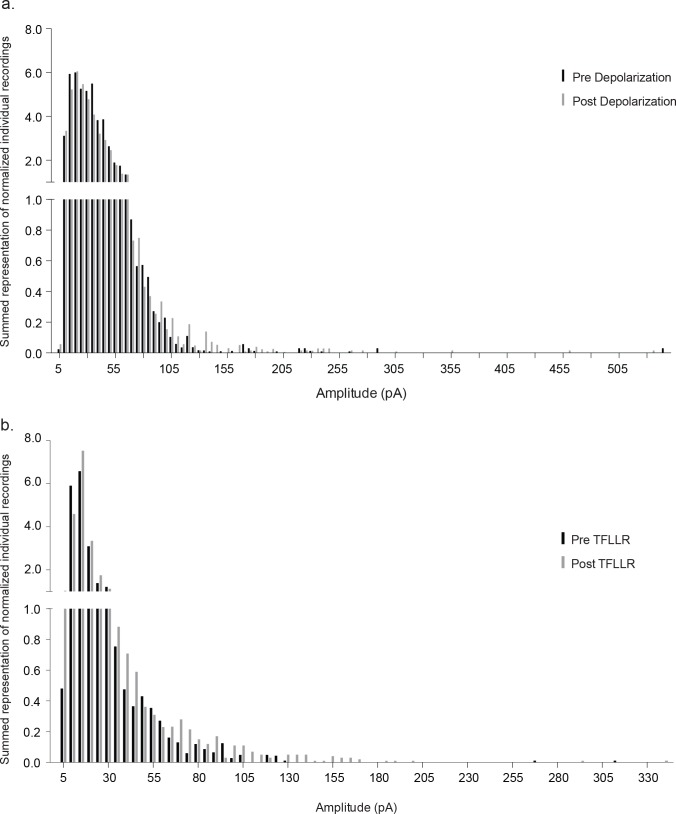
Normalized event number versus amplitude histograms.Histograms for each individual recording were normalized to the largest event number bin and all of the normalized histograms were summed separately for pre- versus post-depolarization (a) and TFLLR (b). (a) The amplitude of synaptic currents induced by astrocyte depolarization (pre-stim: 0.46 ± 1.32, post-stim: 0.42 ± 1.20, n = 14, 5 males and 4 females, Mann-whitney test, p=0.2963). (b) The amplitude of synaptic currents induced by TFLLR application (pre-stim: 0.38 ± 1.16, post-stim: 0.41 ± 1.21, n = 10, 3 males and 2 females, Mann-whitney test, p=0.08).